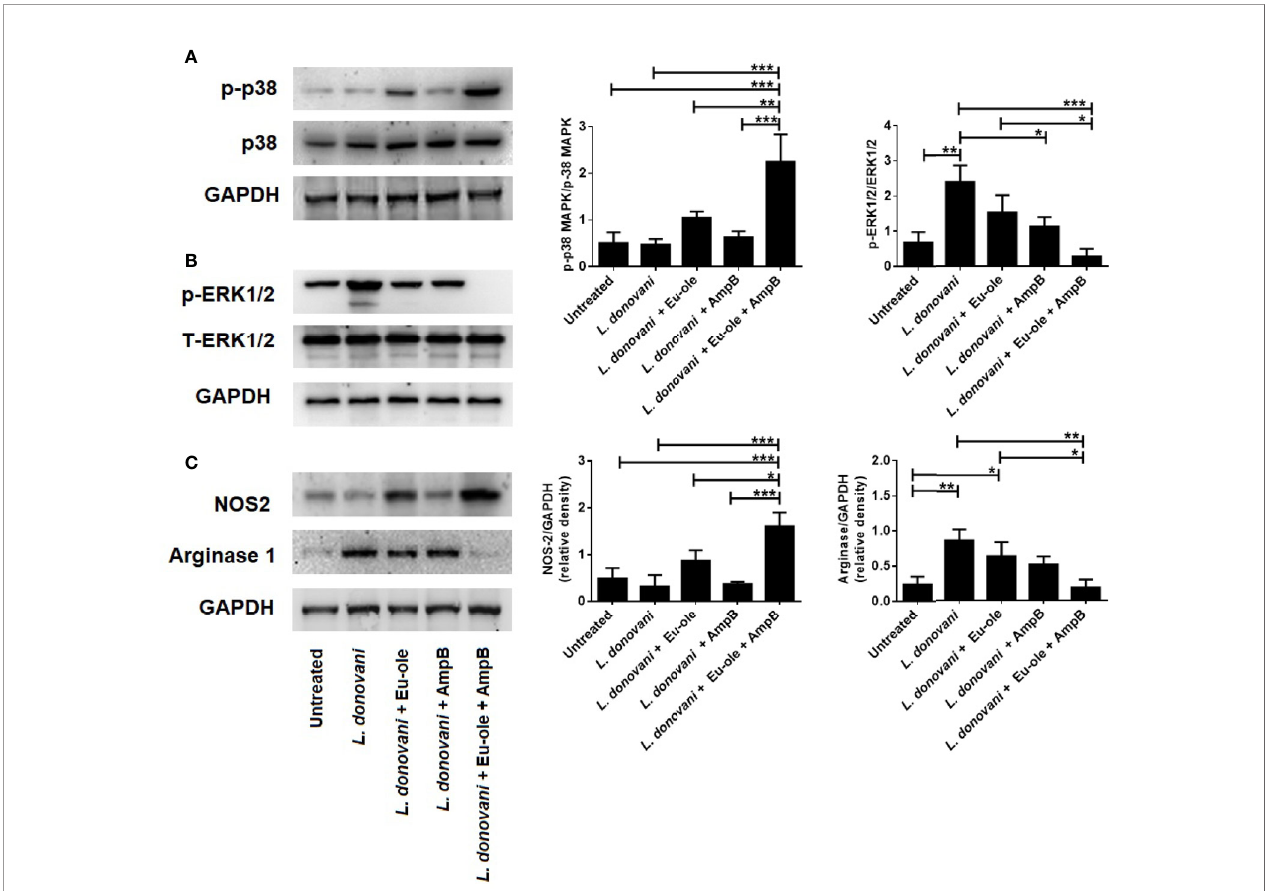
FIGURE 4 | Effect of combination therapy in p38MAPK, ERK1/2 expression in L. donovani infected macrophages. BALB/c derived macrophages were infected L. donovani promastigotes followed by eugenol oleate (2.5 µM) and amphotericin B (0.3125 µM) alone or in combination. After 30 min of treatment, protein was extracted and subjected to western blotting to study the expression of p-p38MAPK, and p-ERK1/2 (A, B) . In a separate set of experiment, after 24 h of treatment, we performed the NOS-2 and arginase 1 expression by immunoblotting (C) . Densitometric analysis was expressed as mean ± SD from triplicate experiments. *p < 0.05, **p < 0.01, ***p < 0.001, signi fi cant differences between the indicated